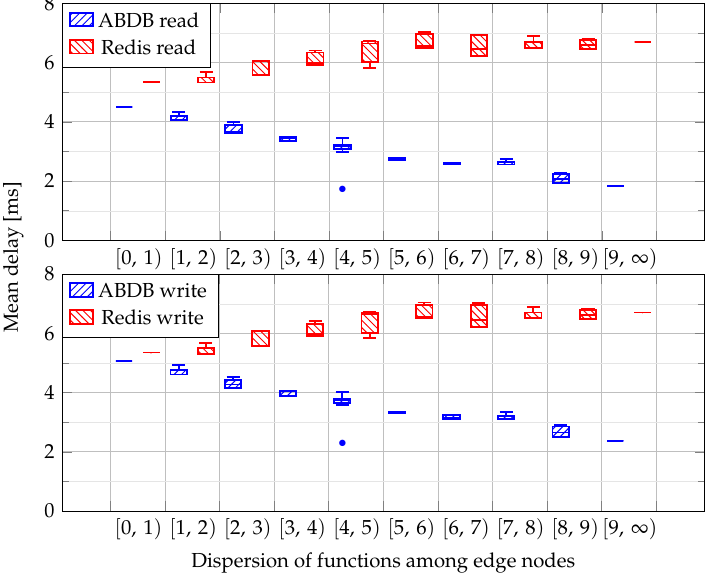
Figure 13. Comparison of ABDB and Redis read and write delays in the “Redis-disfavored”